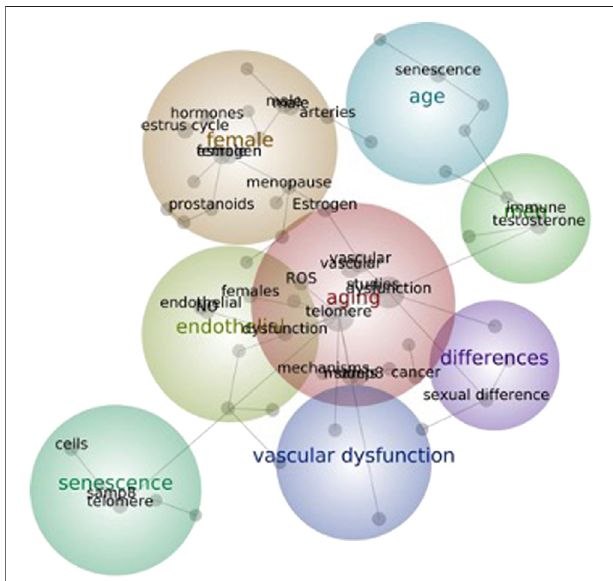
FIGURE 1 | Connections within the vascular system, aging and sex themes. The Concept map was elaborated using the Leximancer algorithm, the original manuscripts and the keywords: aging, senescence, female, male, endothelium and vascular dysfunction. The lines between the concepts (grey circles) show typical pathways linking the concept terms. The size of the grey circles indicates the overall relative frequency of concepts.